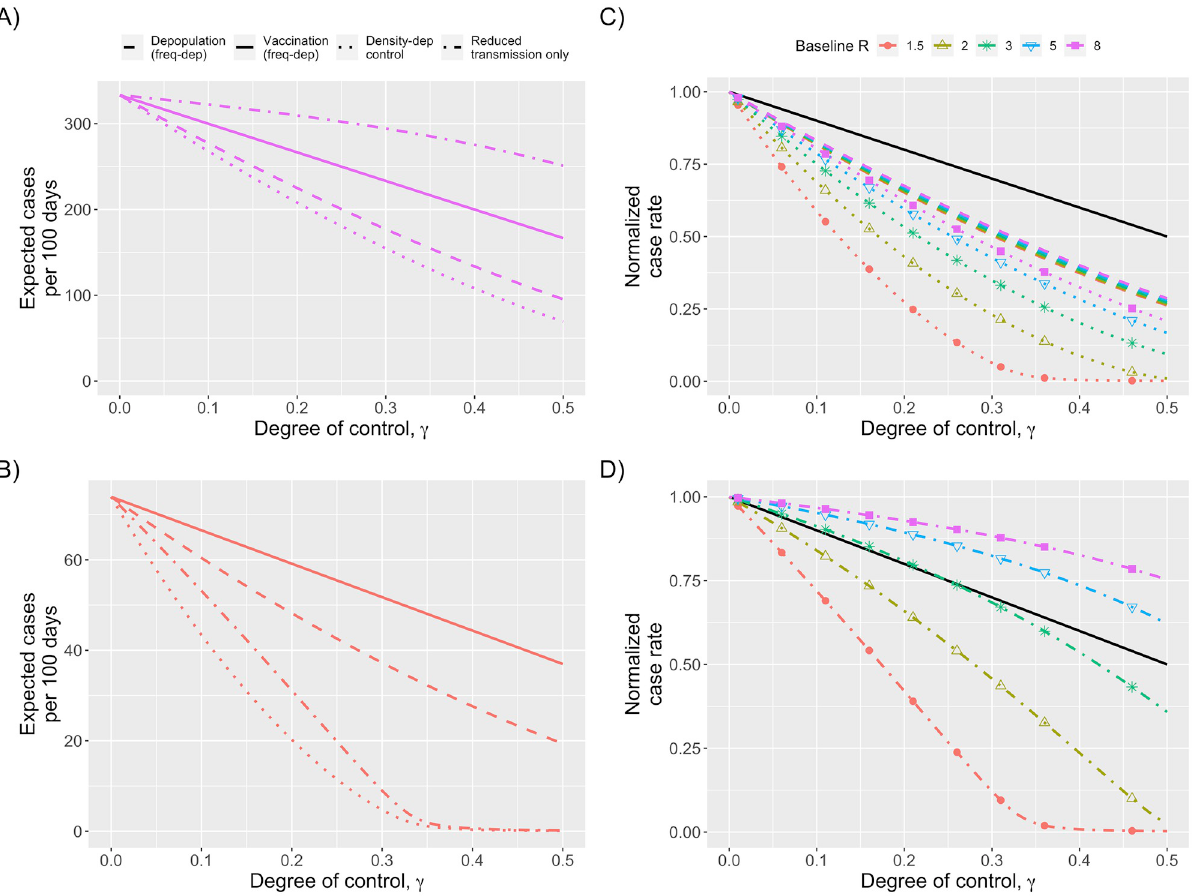
Fig 2. Impact of control measures on decreasing the burden of disease outbreaks in congregate populations. A) The expected number of cases due to outbreaks occurring within 100 days as a function of control. The degree of control, γ , shown on the x-axis provides a continuous parameterization from no control ( γ = 0) to complete eradication of disease ( γ = 1). Each line represents a different mechanism of control as indicated by the legend and modeled per Table 1. The baseline reproduction number is constant for all modes of control ( R B = 8). B) Analogous to panel A, except that R B = 1.5. C) Analogous to previous panels, except that the expected number of cases has been normalized to a rate of one when the level of control is zero. Colors and shapes correspond to different values of the baseline reproduction number, R , as specified by the legend. When vaccination does not change R B (frequency-dependent), the normalized case rate is independent of R B . This is represented by the single black line. All mechanisms of control shown are variations of vaccination or depopulation. Thus the γ value shown on the x-axis can be interpreted as the proportion of the population that has been directly protected from acquiring disease (and possibly infection as well). D) Similar to panel C except that the colored lines now represent a control intervention that effects R without changing the number of susceptible individuals. Thus the γ value shown on the x-axis is the proportion that the reproduction number has decreased from the baseline value of R B